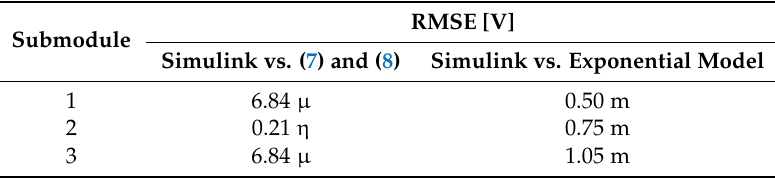
Table 5. Errors in the reproduction of the I-V curve under simulation escenario 2.